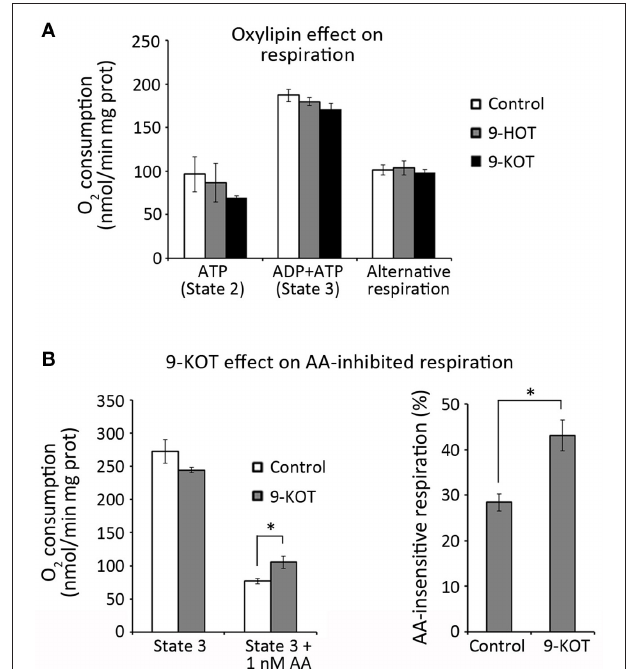
FIGURE 7 | Oxylipin effect on respiration rates of isolated mitochondria. (A) O 2 consumption by the cytochrome (State 2 and State 3) and alternative pathways in the presence of 9-HOT or 9-KOT. (B) Effect of 12.5 µ M 9-KOT on respiration partially inhibited by 1nM AA. Left: O 2 consumption by State 3 mitochondria with or without 9-KOT and AA. Right: Effect of 9-KOT on AA-insensitive respiration, defined as the percent of O 2 consumed by mitochondria after AA treatment, with or without 9-KOT. Asterisks represent significant differences with controls, as indicated ( n = 4, Student’s t -test, * P < 0.05).